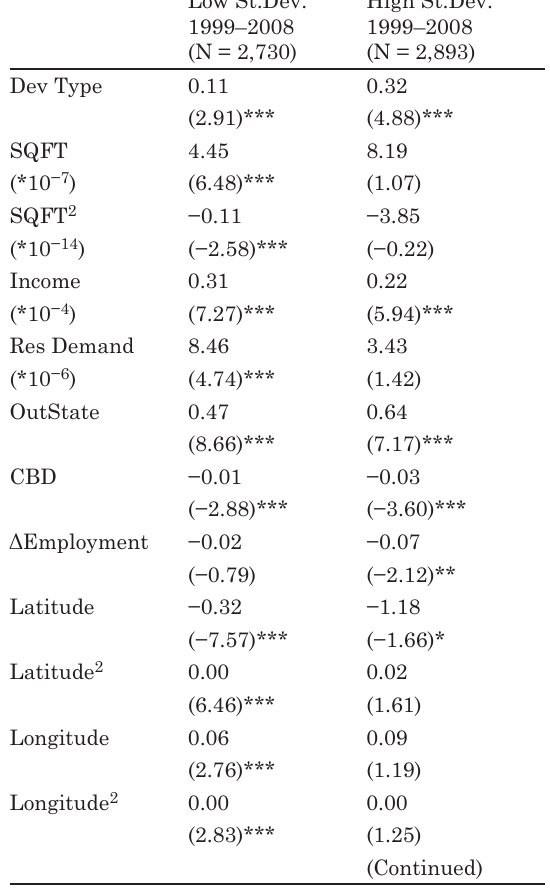
heteroscedasity-consistent t -statistics (in parentheses) of subsamples split by the standard deviation of the natural logarithm of transaction prices (the dependent